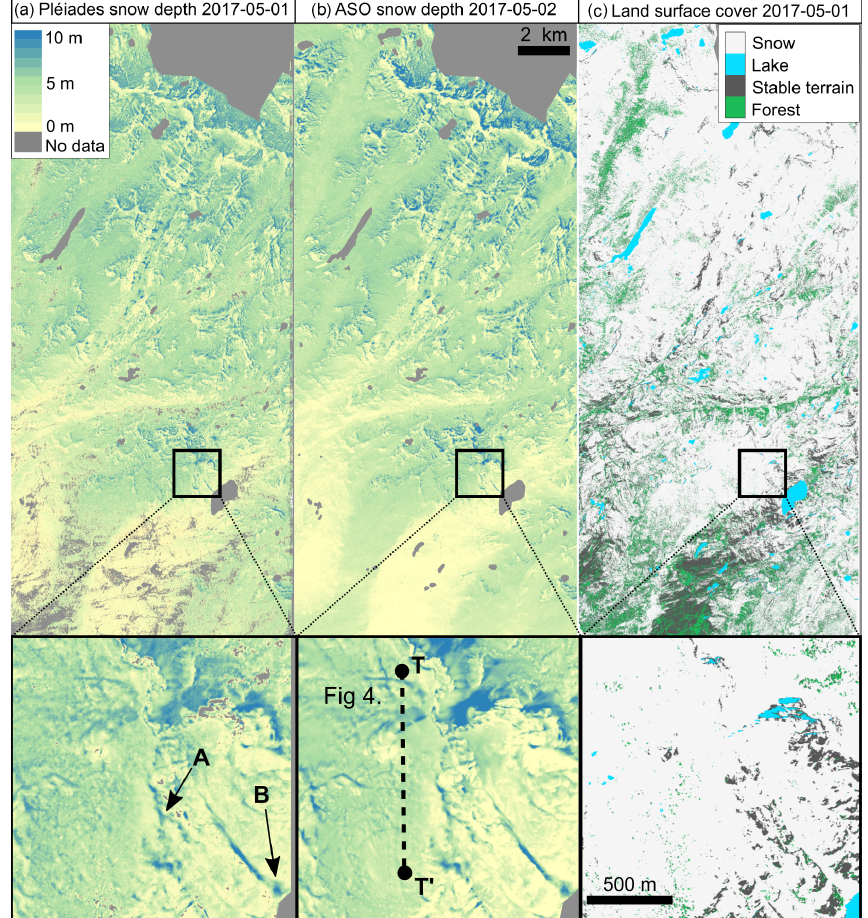
Figure 4. Snow depth maps from Pléiades data on 1 May 2017 (a, d) and from ASO on 2 May 2017 (b, e) . Cornice (spot A) and avalanche deposits (spot B) are visible on Pléiades HS maps (d) . The land surface cover is shown in (c) and (f) over the same area. Black squares in (a–c) are the area shown in (d–f) . The transect T – T (cid:48) is shown in Fig. 5. All datasets have the same spatial resolution (3m). The difference of the maps (a) and (b) (Pléiades minus ASO) is in Fig. 8.